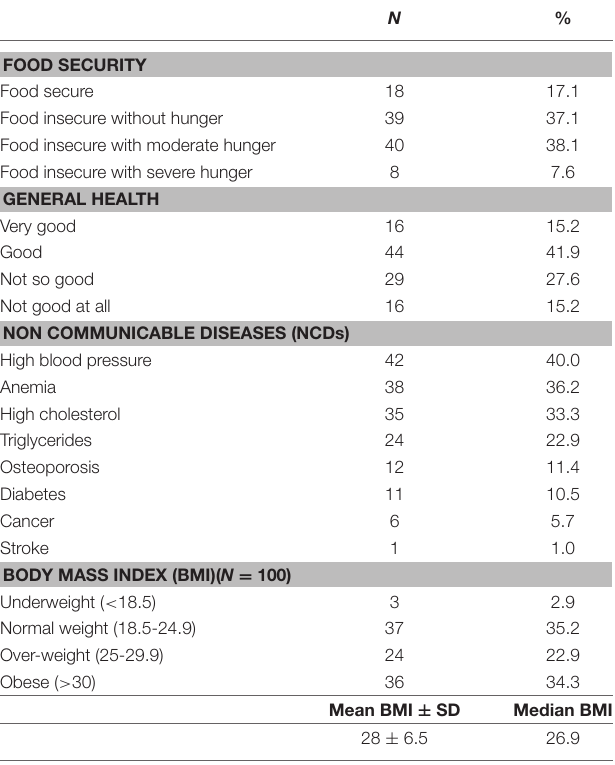
TABLE 3 | Food security, health, and anthropometric status of the study participants.